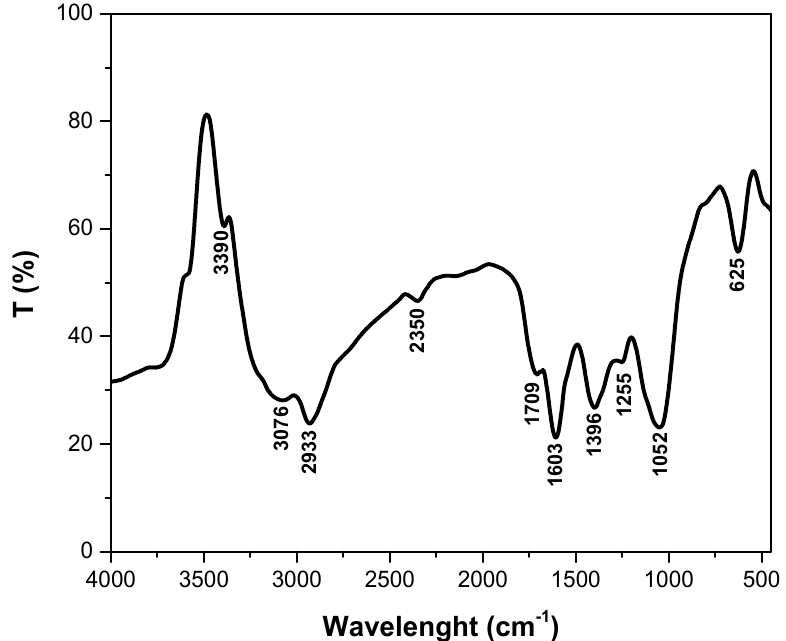
Figure 1. The FTIR spectra of adsorbents obtained from motherwort ( Leonurus cardiaca L.) biomass.